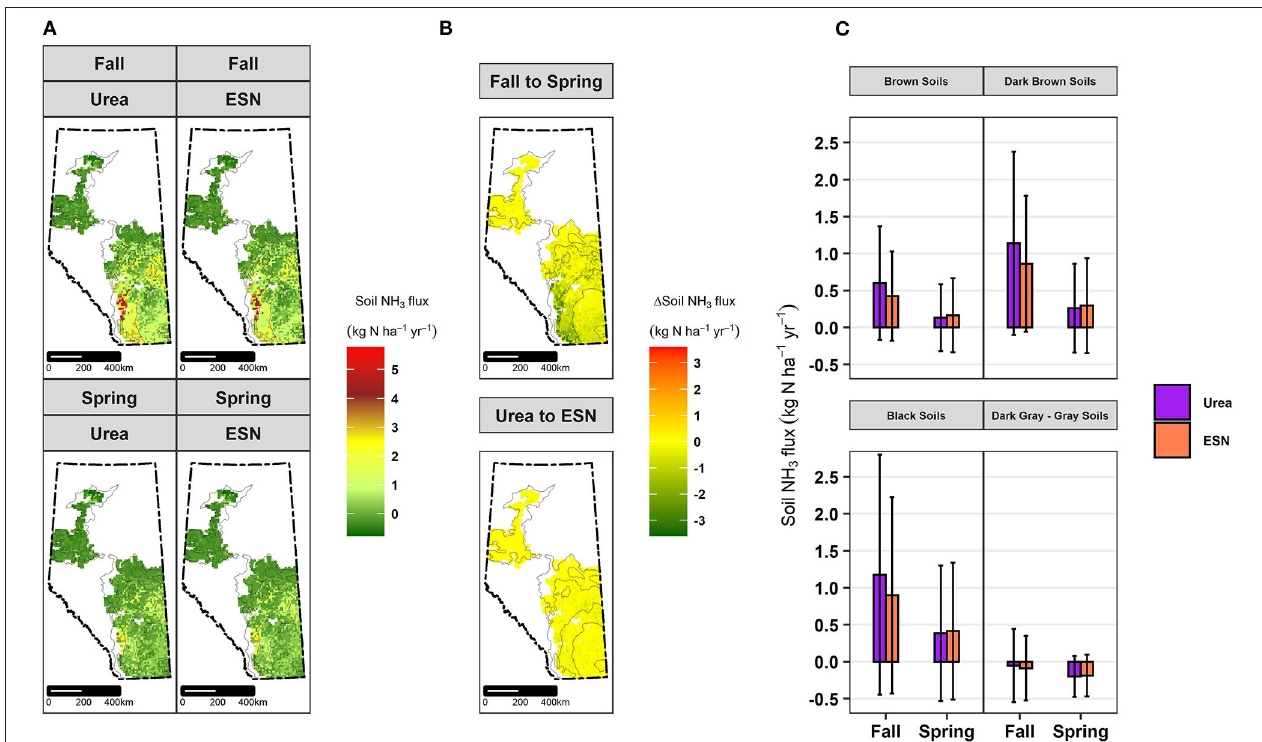
FIGURE 11 | (A) Spatial distribution of modeled annual (January 1–December 31) soil NH 3 fluxes averaged over the simulation period (2011–2015) for each township for each of the fall and spring banded urea and ESN applications across mid-slope landforms of Alberta under simulated barley cultivation. Positive fluxes